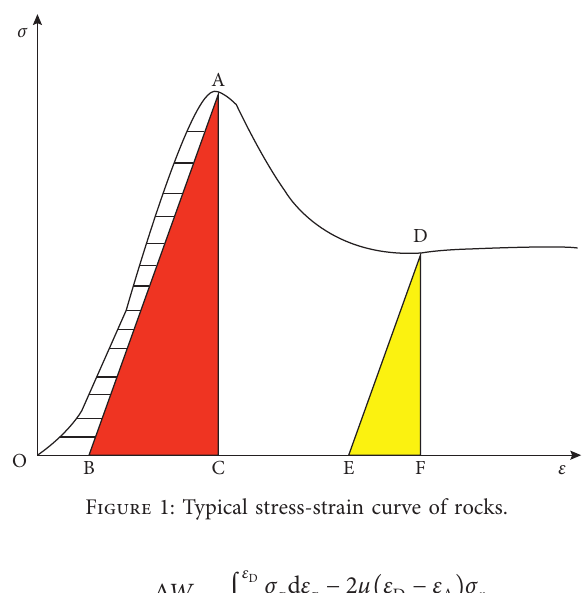
Figure 1: Typical stress-strain curve of